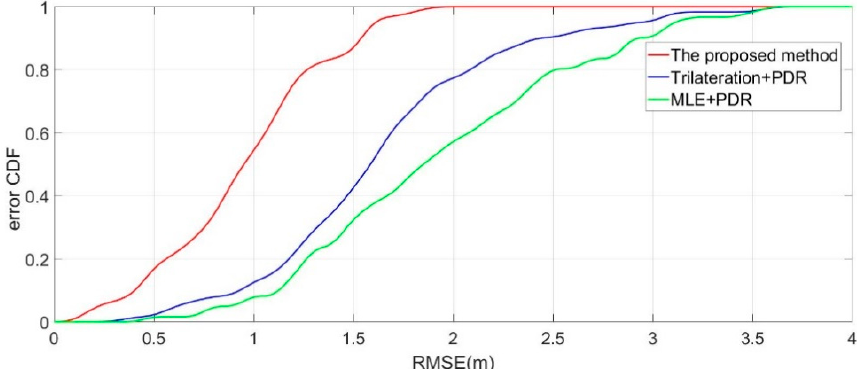
Figure 11. The cumulative distribution function (CDF) of the three algorithms in the test environment (the average NLOS rate ≈ 0.22).